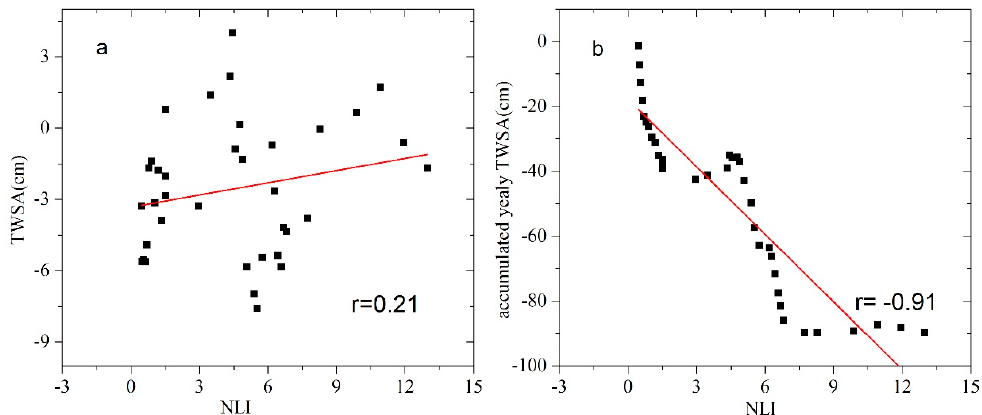
Figure 7. The relationship between night light index (NLI) and TWSA as evaluated by the Pearson correlation coefficient at the 5% level. ( a ) the relationship between NLI and TWSA (r = 0.21, p > 0.05); ( b ) the relationship between NLI and accumulated yearly TWSA (r = − 0.91, p < 0.01).